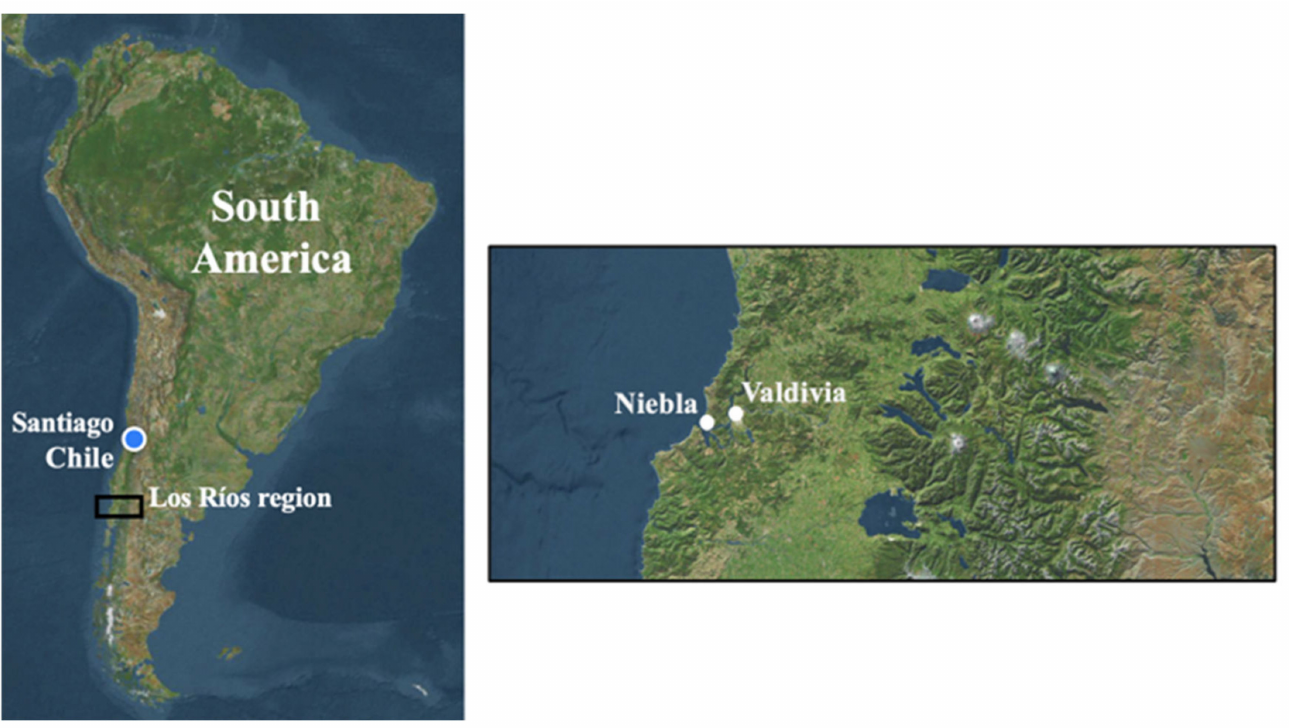
Figure 2. Location of the 72 case studies analysed in South